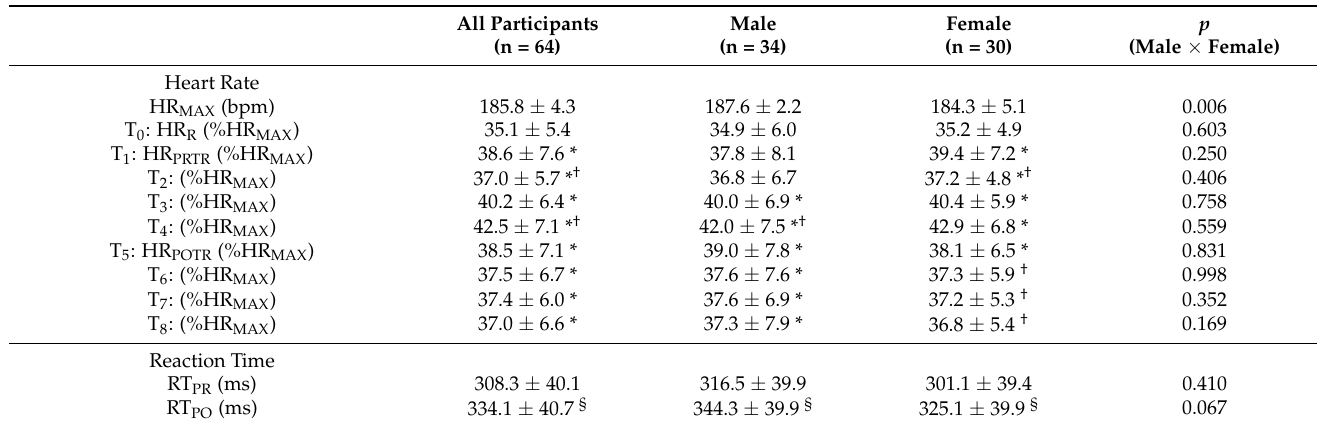
Table 1. Mean and SD of hearth rate (HR) and reaction time (RT) for men and women. All Participants (n =